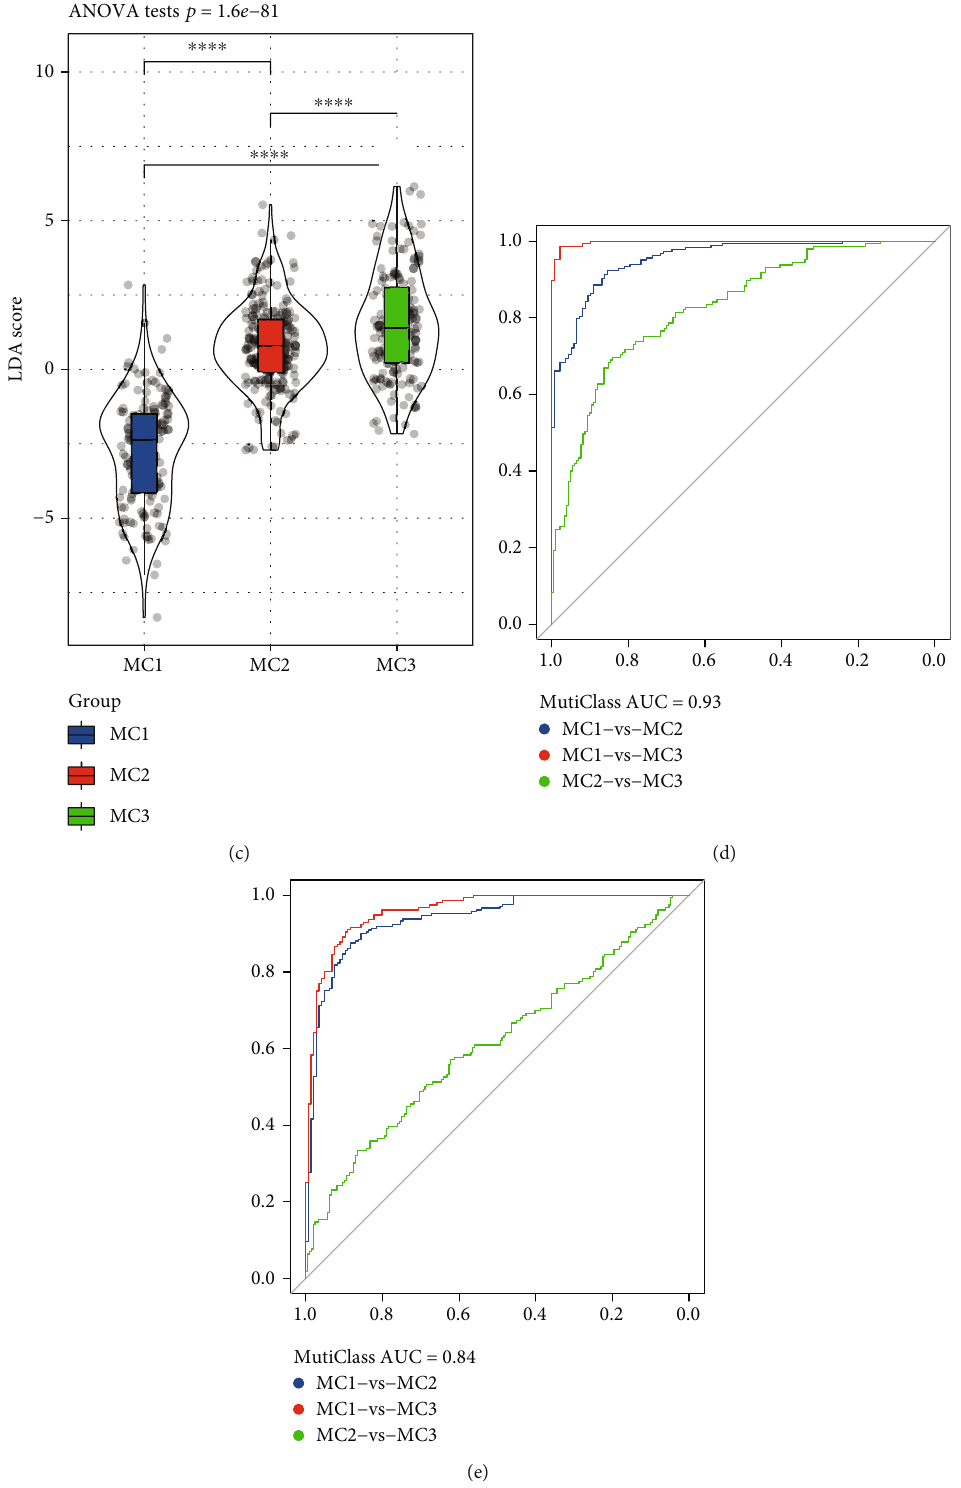
Figure 8: (a) Relationship between the fi rst two features in the RNASeq metabolic feature index and metabolic subtypes. (b) Di ff erences in the immune feature index among di ff erent subtypes in the RNASeq cohort. (c) Di ff erences in the immune feature index among di ff erent subtypes in the GSE cohort. (d) ROC curve of the immune characteristic index in the RNASeq cohort. (e) ROC curve of the immune characteristic index in the GSE cohort. ANOVA test was conducted among three groups. ∗∗∗∗ P < 0 : 0001